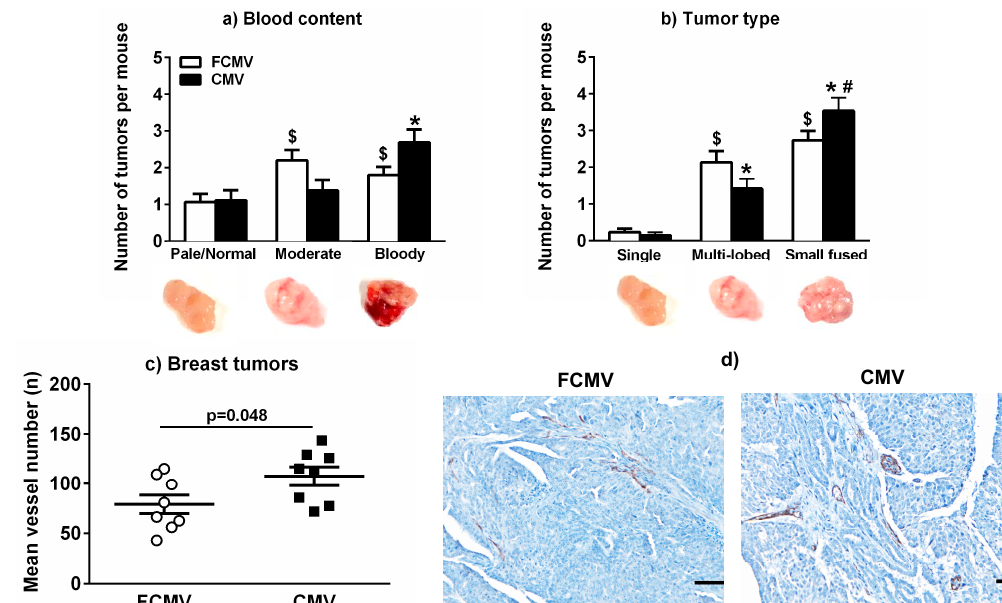
Figure 2. MMTV-PyVT mice latently infected with mCMV developed more breast tumors with severe phenotypes associated with metastasis. The tumors were categorized as pale/normal, moderate or bloody ( a ) or as a single tumor, multilobed or fused small tumors ( b ) in 25 control mice treated with a filtered control solution (FCMV) or in 23 mCMV-infected mice. The mean number and SEM for each type of tumor per mouse are shown, and the p -values were calculated by a two-way ANOVA and Tukey’s post hoc test. A significant interaction between the treatment and phenotype was found in Figure 2a ( p = 0.009) and Figure 2b ( p = 0.01). $ = p < 0.05 compared to the pale/normal or single tumor in the FCMV group; * = p < 0.05 compared to the pale/normal or single tumor in the mCMV group; # = p < 0.05 compared to multilobed in the CMV group. The number of blood vessels was assessed by the CD31 staining of sections of breast tumors from the mCMV-infected mice ( c ), n = 8. The representative images of stained sections ( d ): The images were taken with a 20 × magnification lens. Scale = 100 µ m. The p -value was calculated using a Student’s t -test.